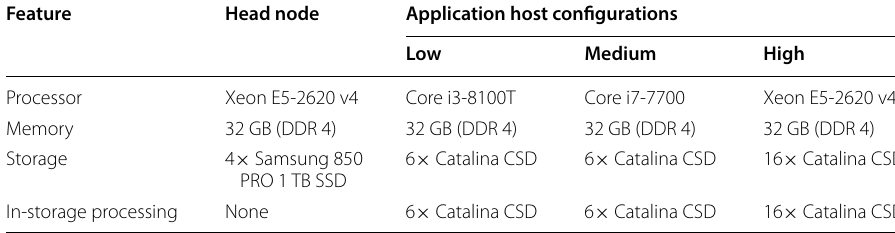
Table 2 Specifications of the hosts in the developed system for running experiments Feature Head node Application host configurations Low